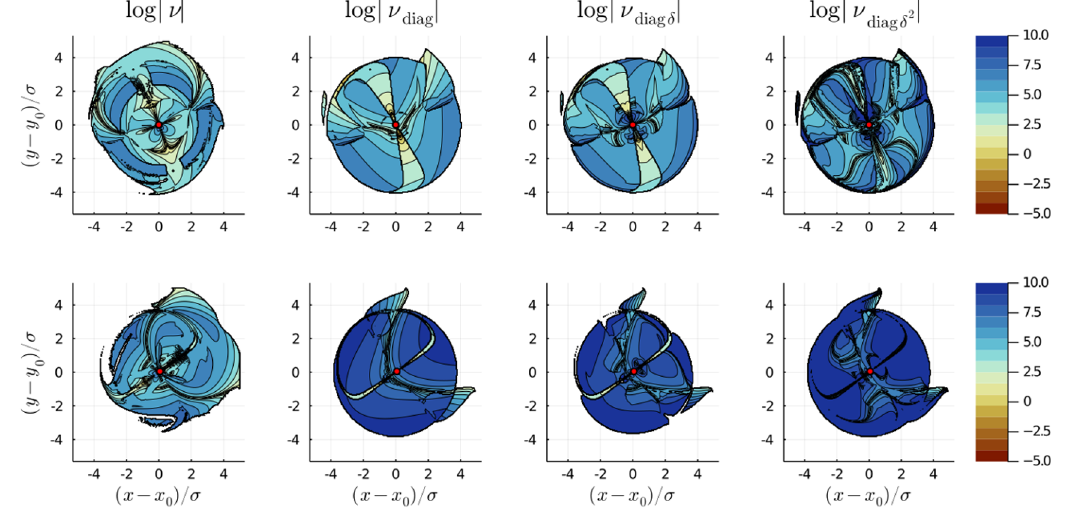
Figure 4 . We show the implied ν from the solution with the smallest | ξ | , for parameter sets 1 and 2 in the upper and lower rows respectively. While the diagonal method begins converging for parameter set 1, with parameter set 2 and its larger λ , most of the surveyed range is orders of u magnitude misestimated. Even in the perturbatively stable regions, ν converges noticably slower than (cid:15) or ω/H . Comparing with (3.53)–(3.55), we see that corrections to ν depend on a higher power of λ u /λ k